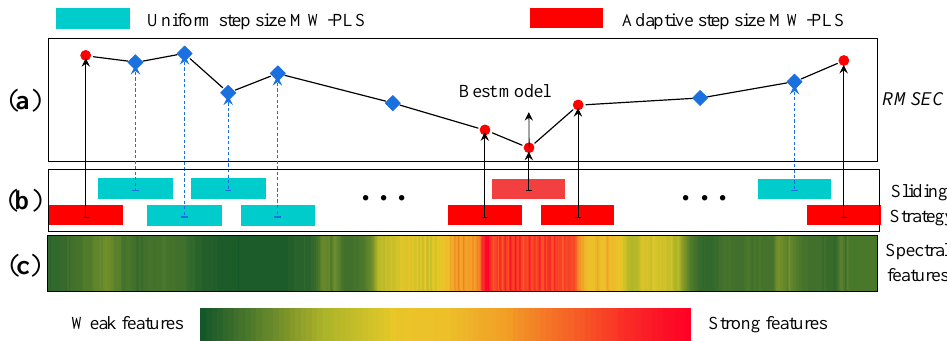
Figure 2. Process diagram of sliding window local modelling strategy: ( a ) RMSECV values during the sliding window. Red dots indicate ASS-PLS and blue dots indicate MW-PLS. ( b ) Window position for local modelling. ( c ) Analyse characteristic intensities of spectral